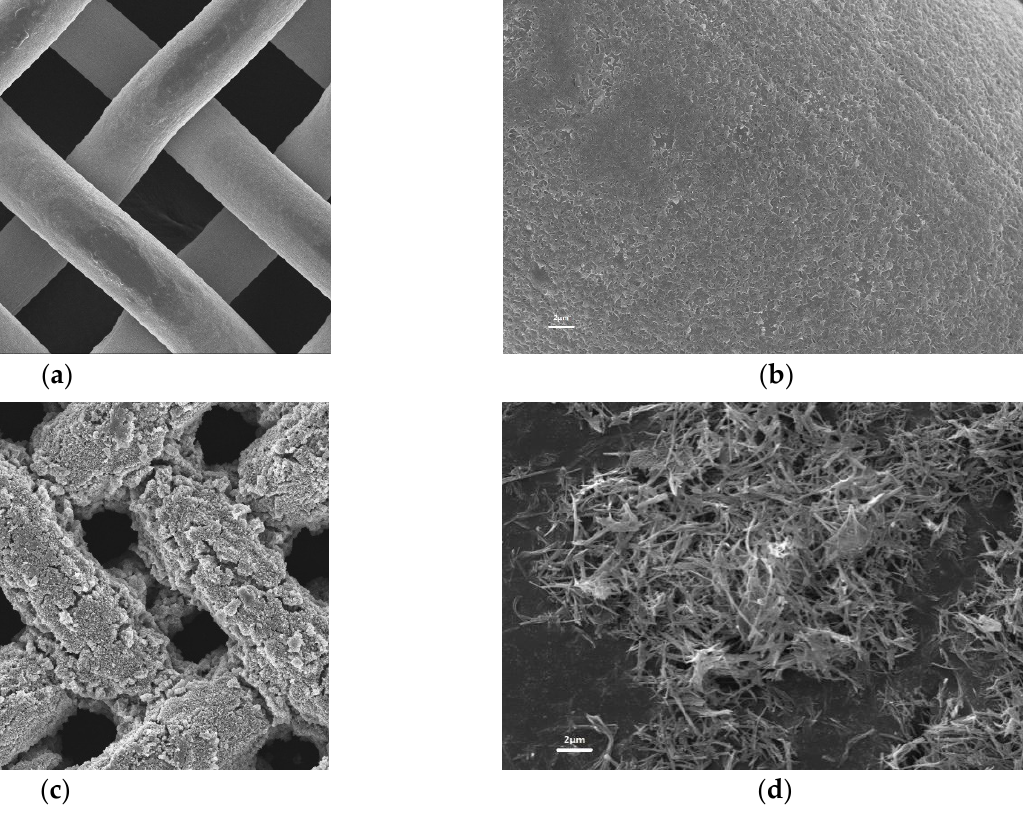
Figure 3. SEM images of ( a , b ) uncoated and ( c , d ) coated mesh.